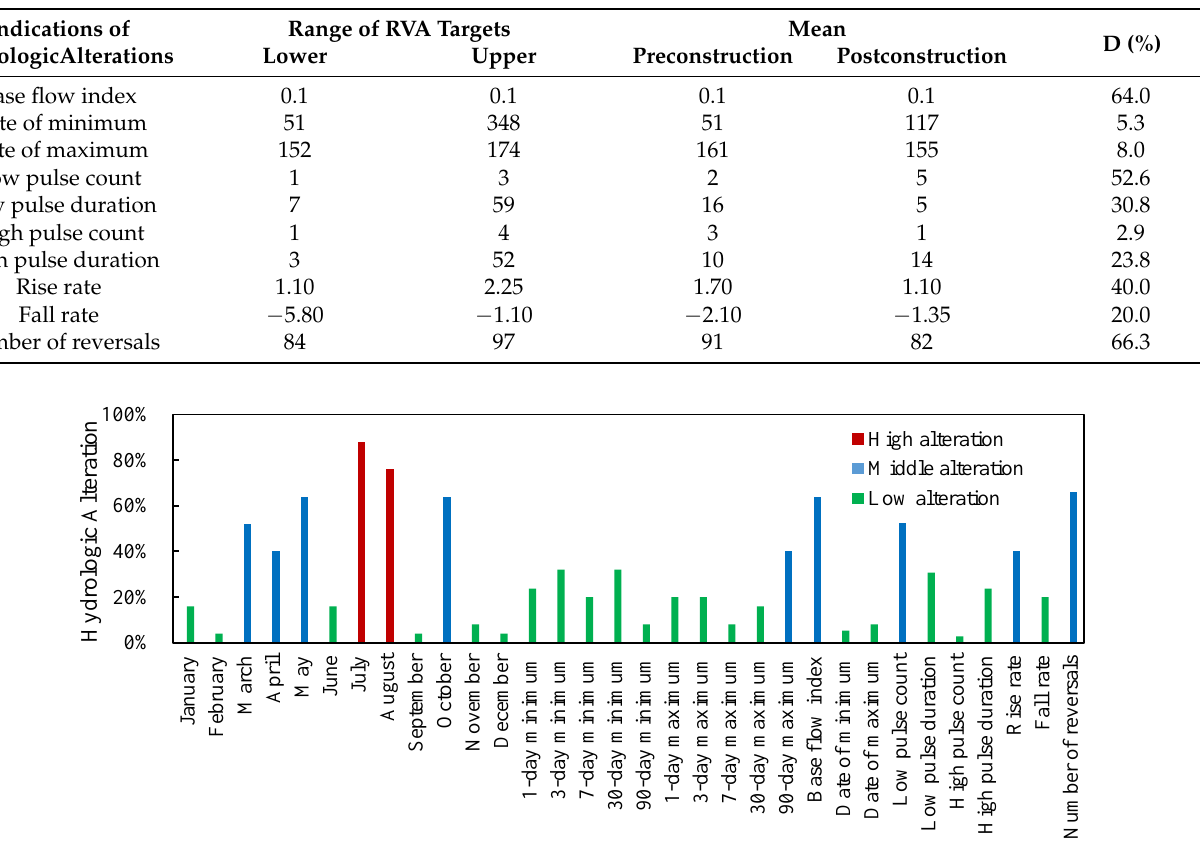
Figure 6. Indicators of Hydrologic Alteration (IHA) of the Burqin hydrological station.